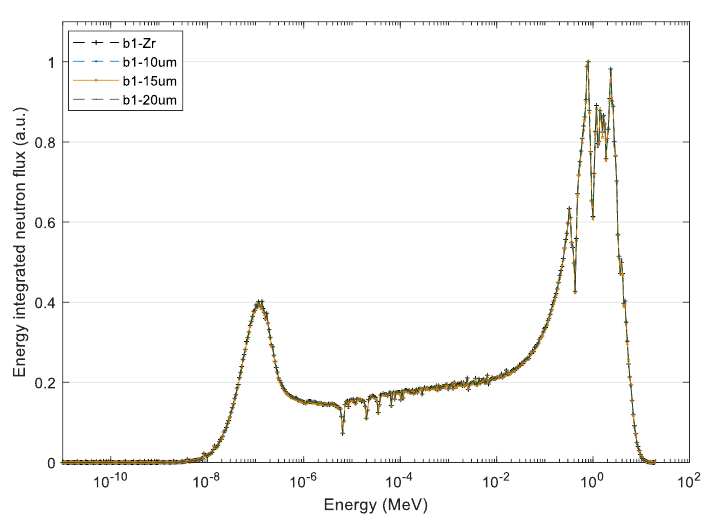
Figure 7. Neutron flux spectrum for b1 APR-1400 fuels assembly.